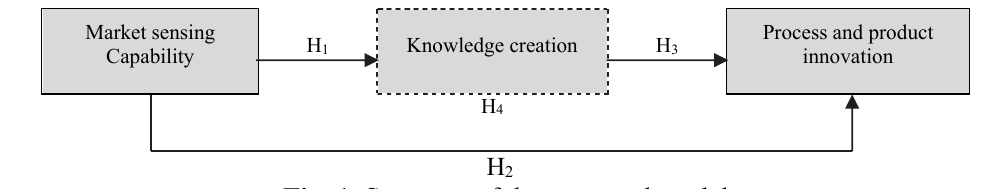
Fig. 1. Structure of the proposed